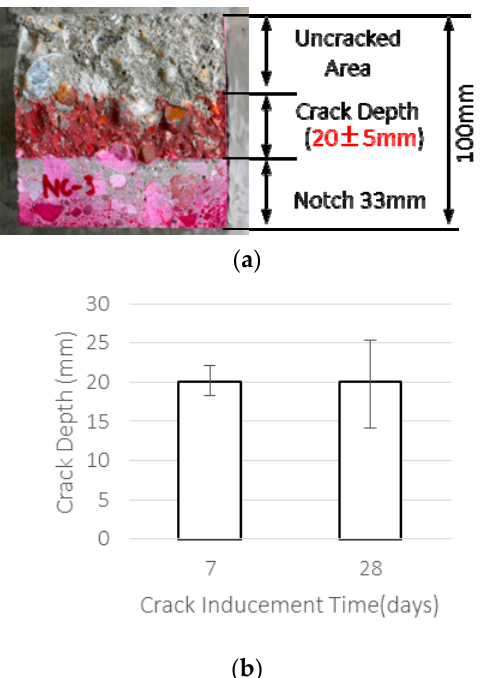
Figure 15. Investigation of crack depth by ink injection. ( a ) Stained crack part; ( b ) measured crack depth.